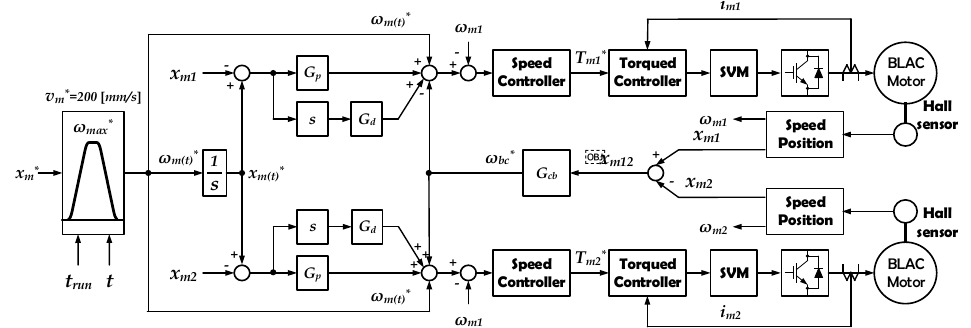
Figure 10. Block diagram of the proposed position control